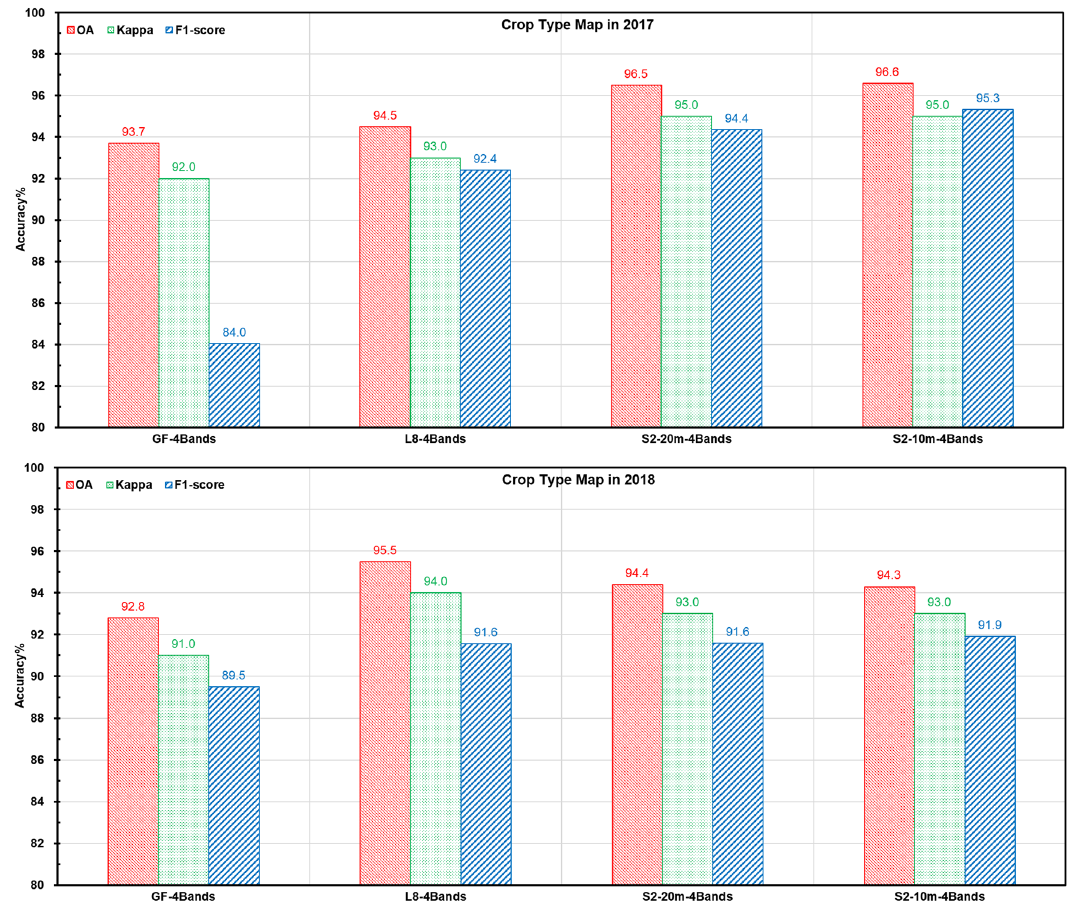
Figure 3. The accuracies of experiment 1.